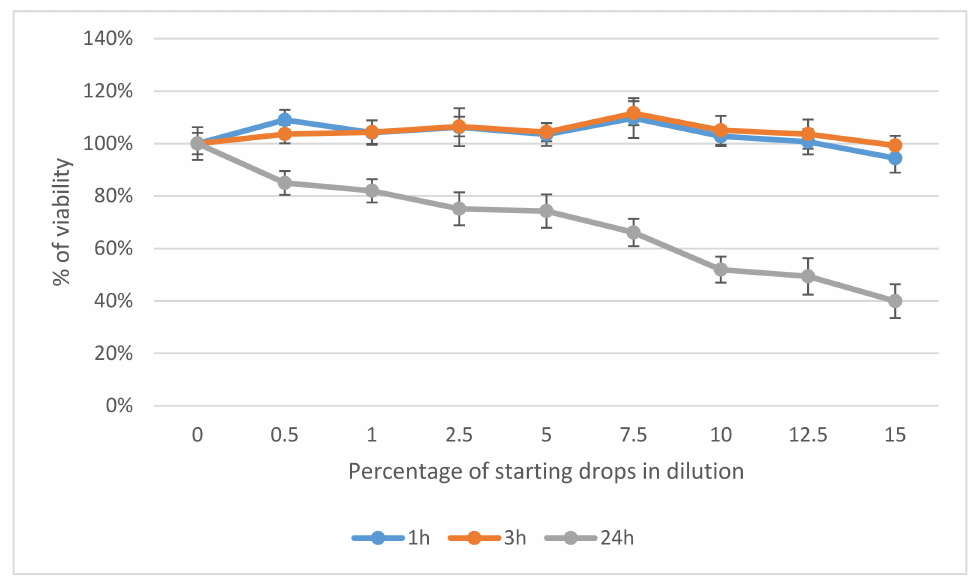
Figure 1. Effect of Ozodrop ® preparation on the viability of human corneal epithelium (pRSV-T) in vitro, after 1, 3, and 24 h of incubation. Cell viability was determined by means of neutral red cytotoxicity (NR)